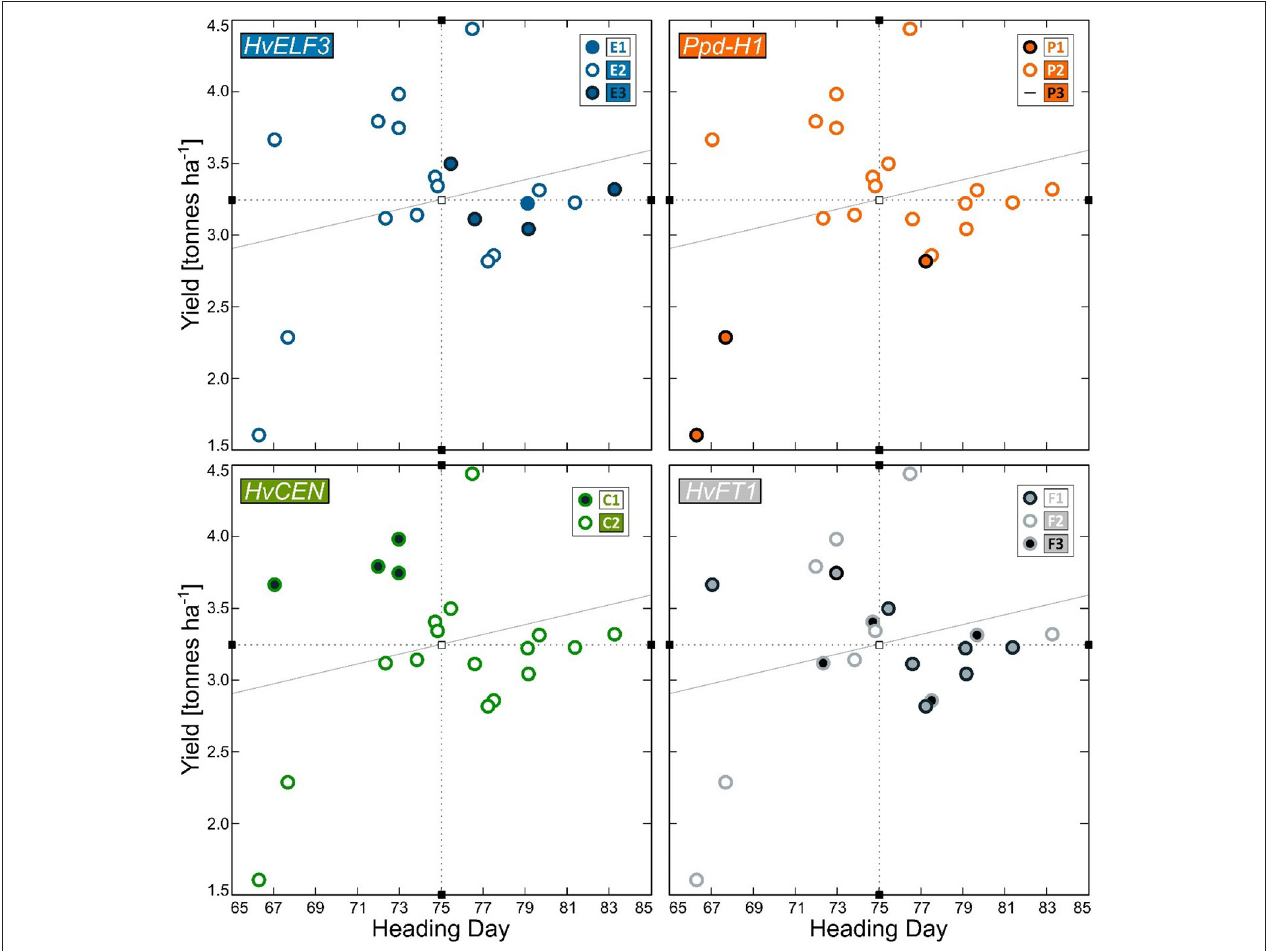
FIGURE 4 | Heading day (days from sowing to heading) and Yield (t ha − 1 ) for 20 barley genotypes grown in field trials in Iceland in the period 1987–2014. The four plots show results for the four re-sequenced genes HvELF3 (blue), Ppd-H1 (orange), HvCEN (green), and HvFT1 (gray). The alleles are indicated with differently color-coded dots. Mean heading day and yield are indicated as dotted lines and the sloping gray line indicates the